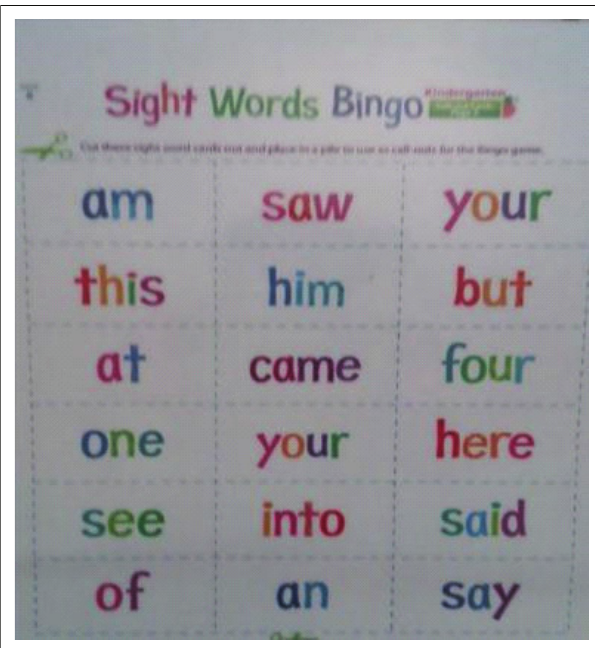
FIGURE 3: Sight words.